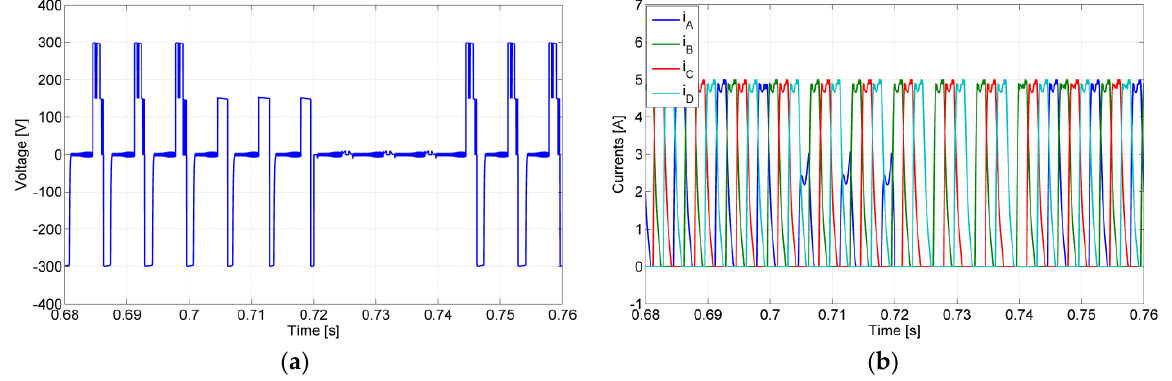
Figure 17. Simulation test with the converter operating in normal mode until t = 0.7 s, an open-switch fault ( S 11 ) after that instant and another open-switch fault ( S 21 ) at t = 0.72 s ( a ) winding voltage of phase A ; ( b ) winding currents. Fault-tolerant mode after t = 0.74 s.